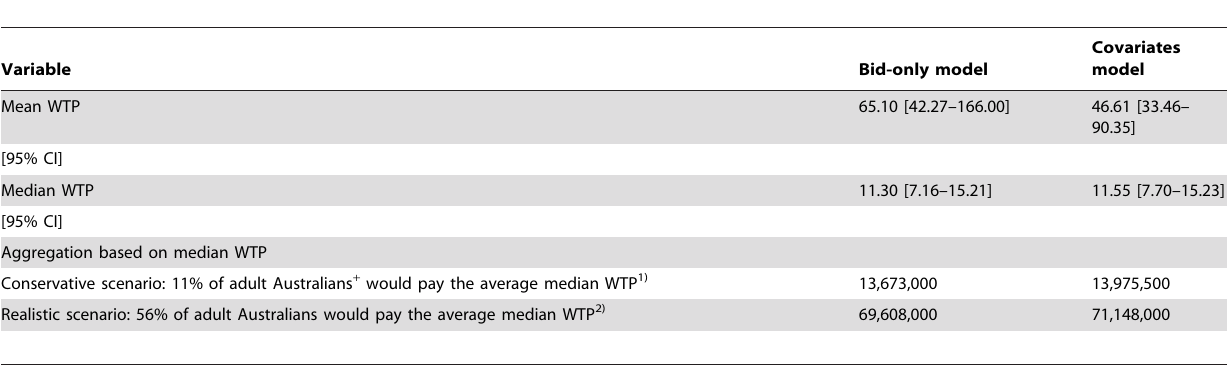
Table 7. WTP estimates (in AUD) for Australian threatened bird conservation and aggregation of these